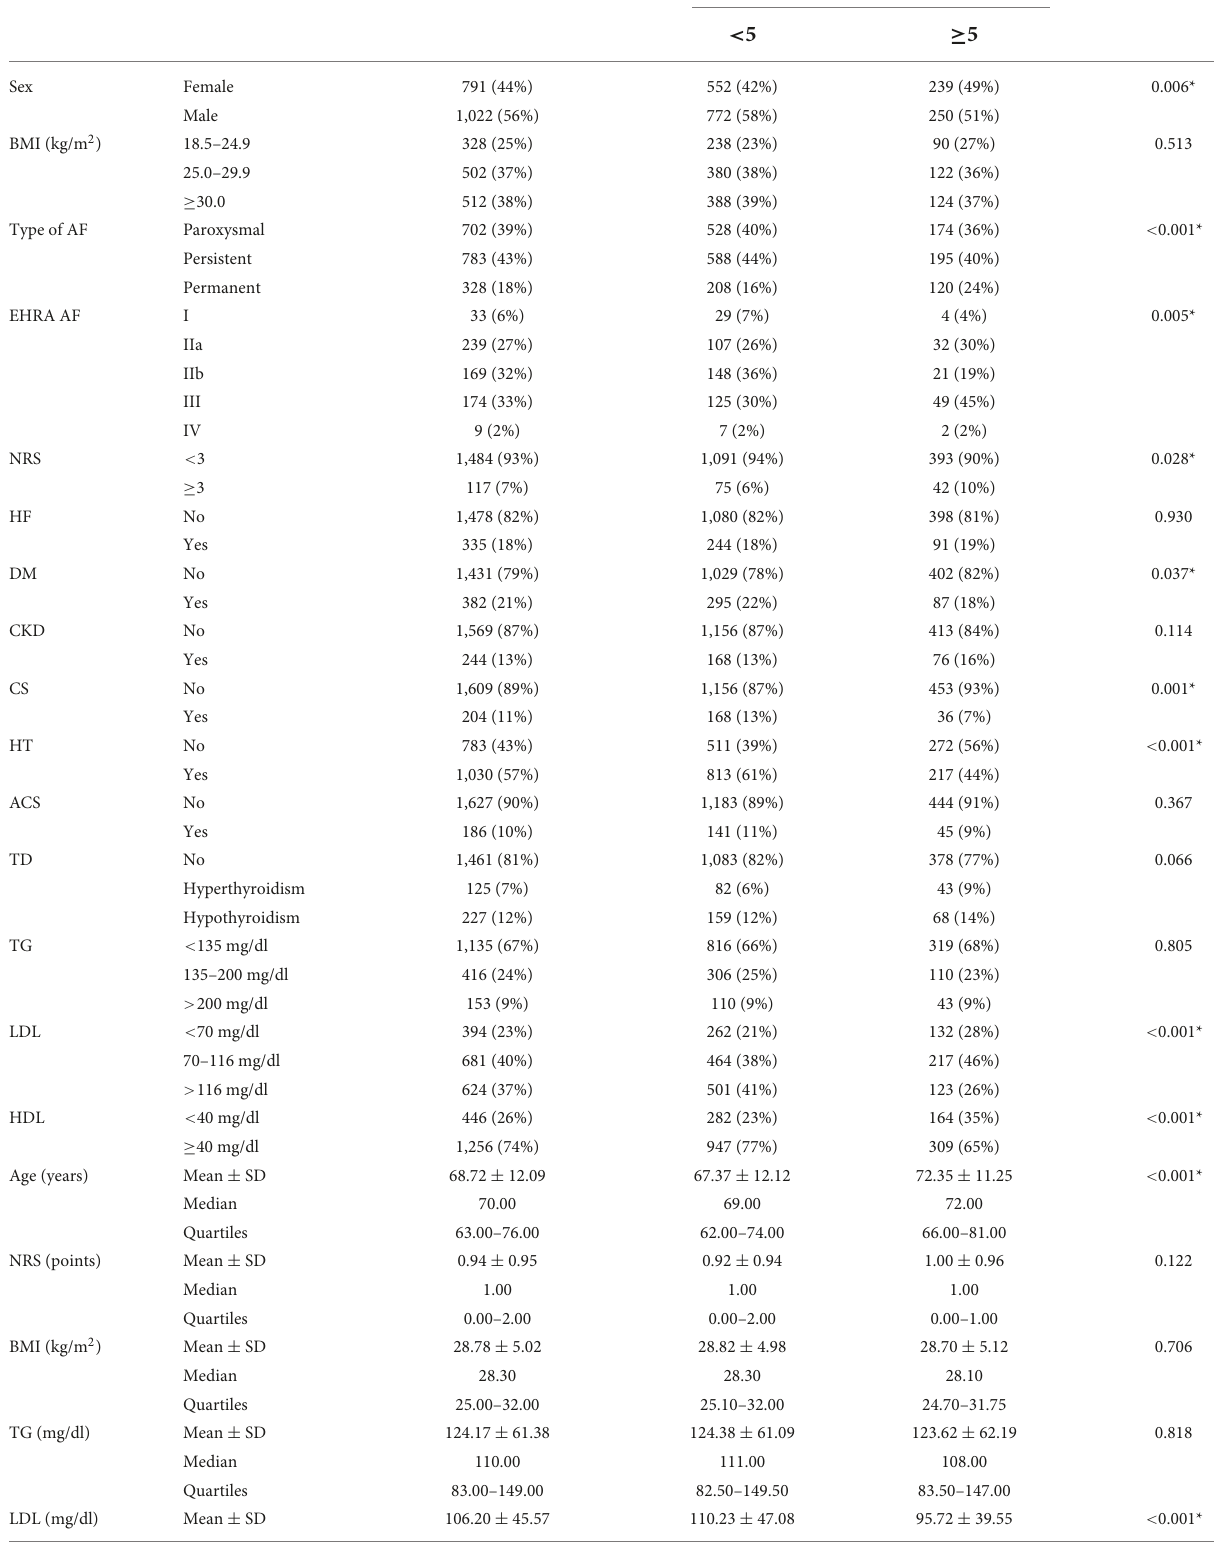
TABLE 1 Study group characteristics and comparison of quantitative and qualitative variables relative to length of hospital stay.